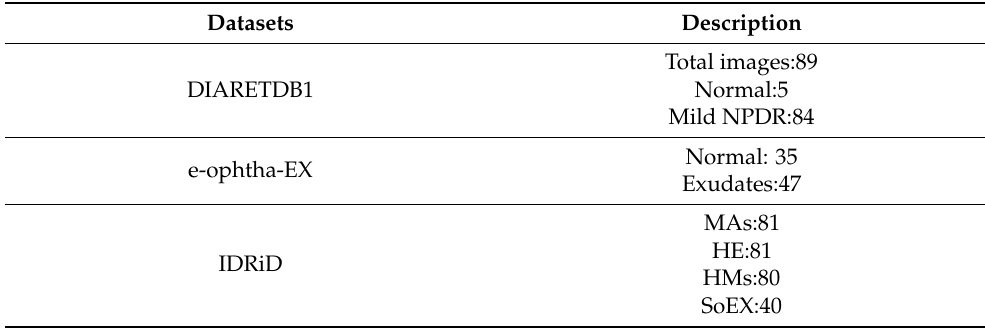
Table 4. Description of segmentation datasets.